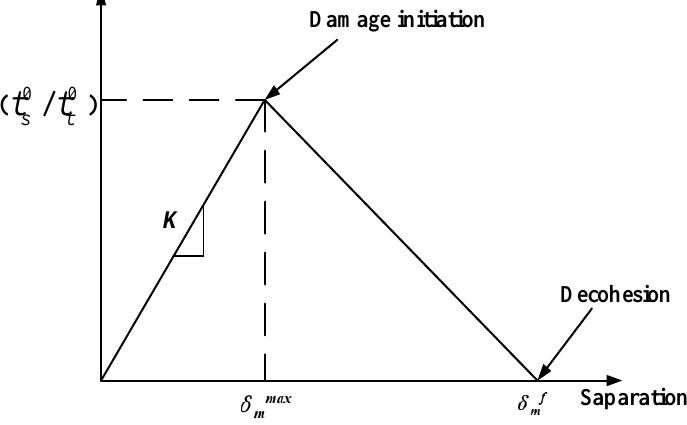
Figure 4. Stress–strain constitutive relationship of resin matrix.